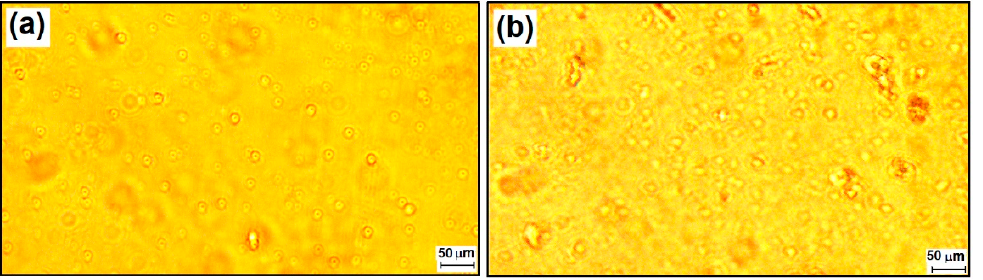
Figure 2. Optical images of M2-CC nanocomposites deposited as films on glass ( a ) and PET supports ( b ).